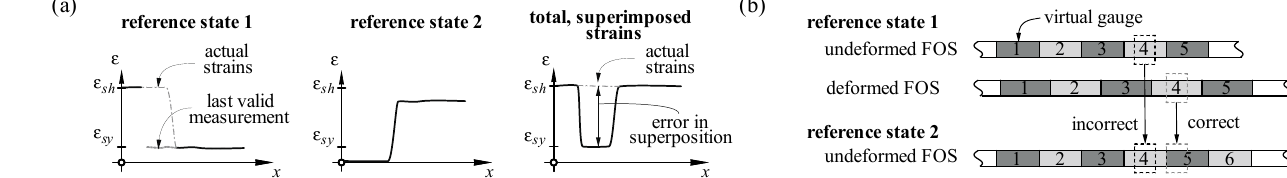
Figure 3. Potential issues in DFOS measurements with multiple reference states: ( a ) Loss of correlation when measuring steel with a yield plateau; ( b ) potential incorrect superposition when setting a new reference state that defines new virtual gauges with a different location.